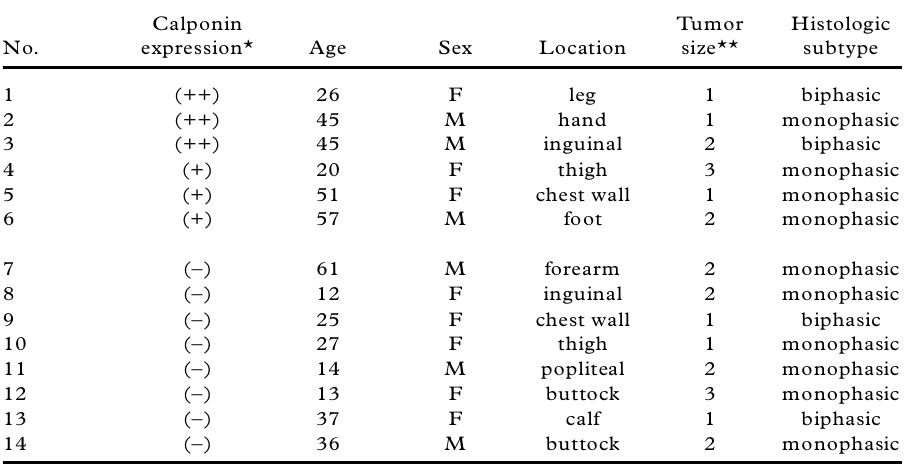
Table 2. Clinicopathological data of the patients with synovial sarcoma